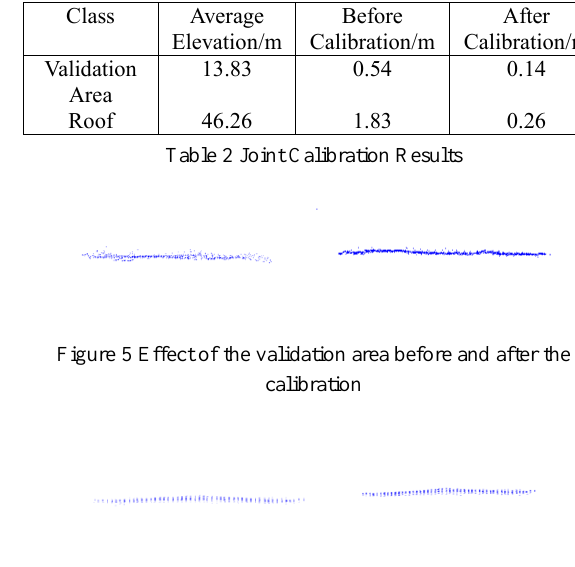
Figure 5 Effect of the validation area before and after the calibration